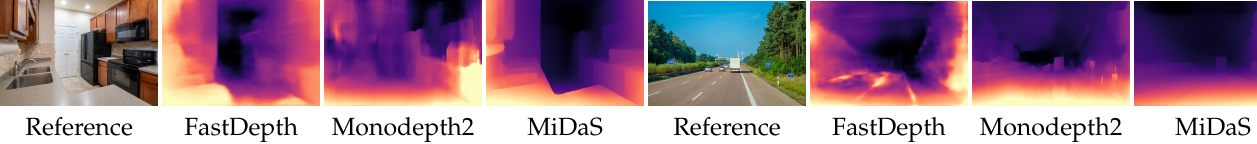
Figure 3. Predictions in the wild. We provide qualitative results for indoor and outdoor Internet images. For each network, we used the checkpoints publicly available. It can be noticed how the networks trained on a single dataset, both in a supervised (FastDepth) and self-supervised (Monodepth2), are not able to generalize well on a different setup. On the contrary, the network trained on various datasets (MiDaS) produced better results. Images from Pexels